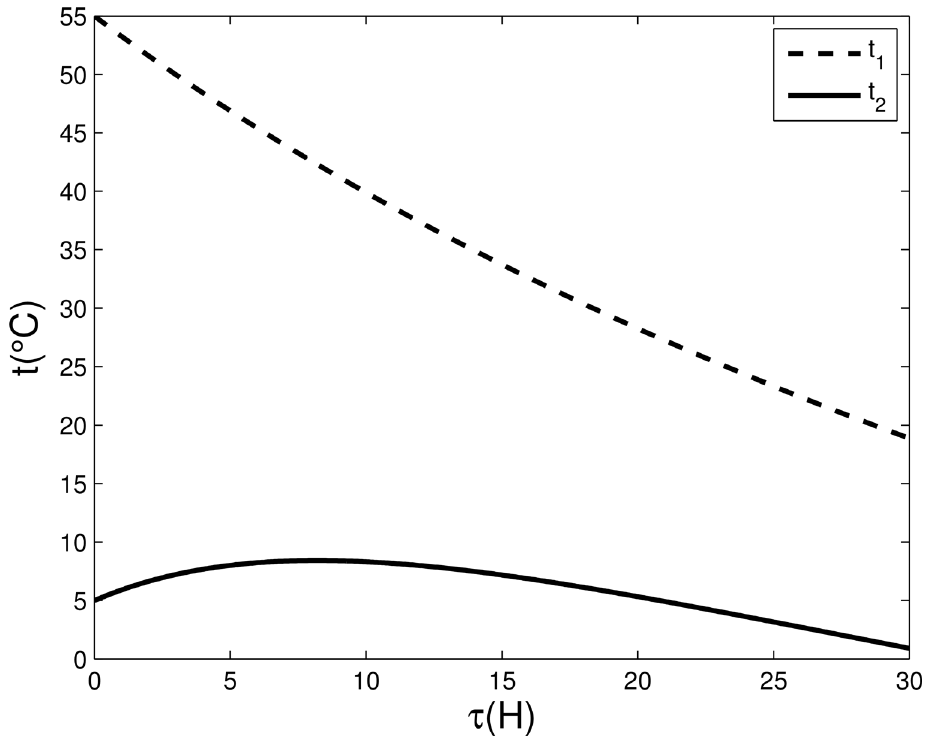
Fig 8. The temperature of the water ( T 1 ) and the blood ( T 2 ) change with time in the given circumstance.